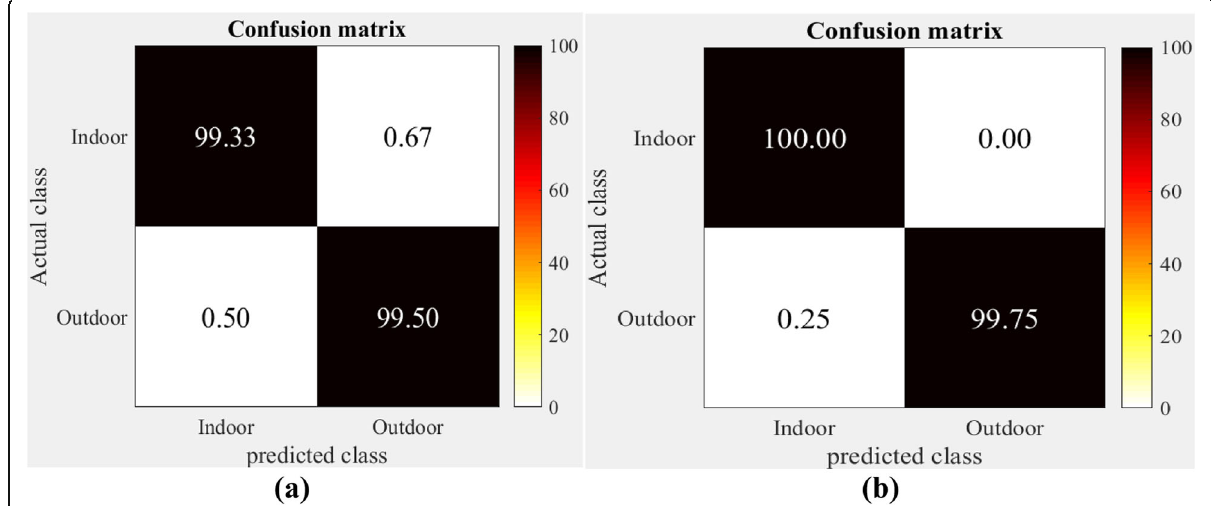
Fig. 8 Confusion matrices obtained for Spatial color gist wavelet descriptors on Indoor Outdoor dataset. a Linear kernel; b Radial basis function